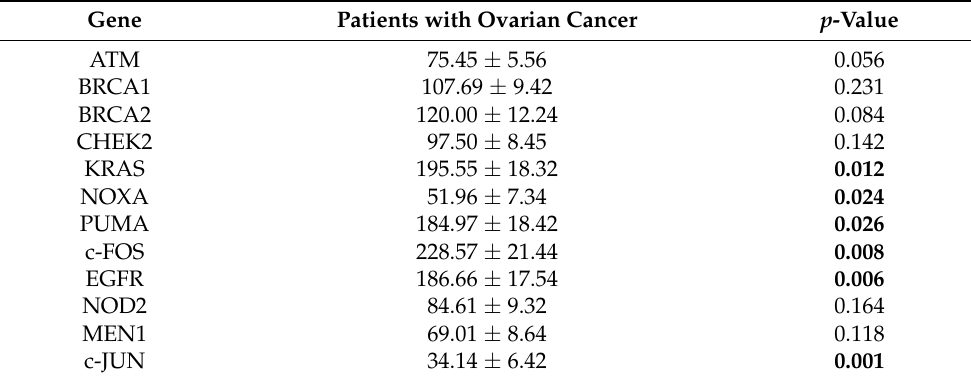
Table 3. Summary of mRNA expression analysis of selected genes in patients with ovarian cancer in comparison to the control group.